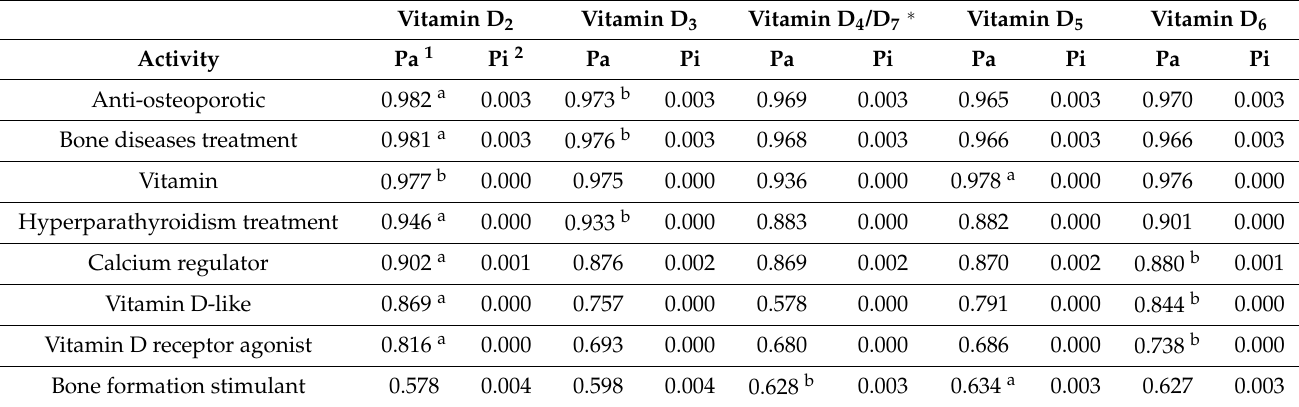
Table 1. The predicted biological activities of 1, 25-di(OH)-vitamin